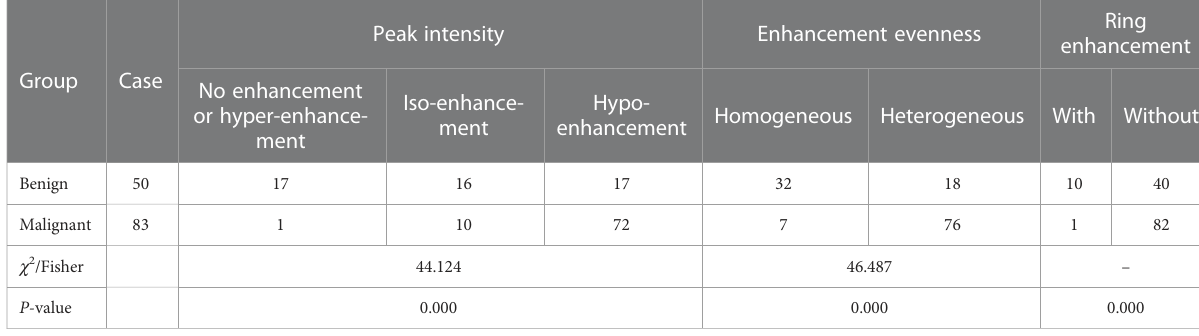
TABLE 2 Enhancement patterns of all thyroid nodules.